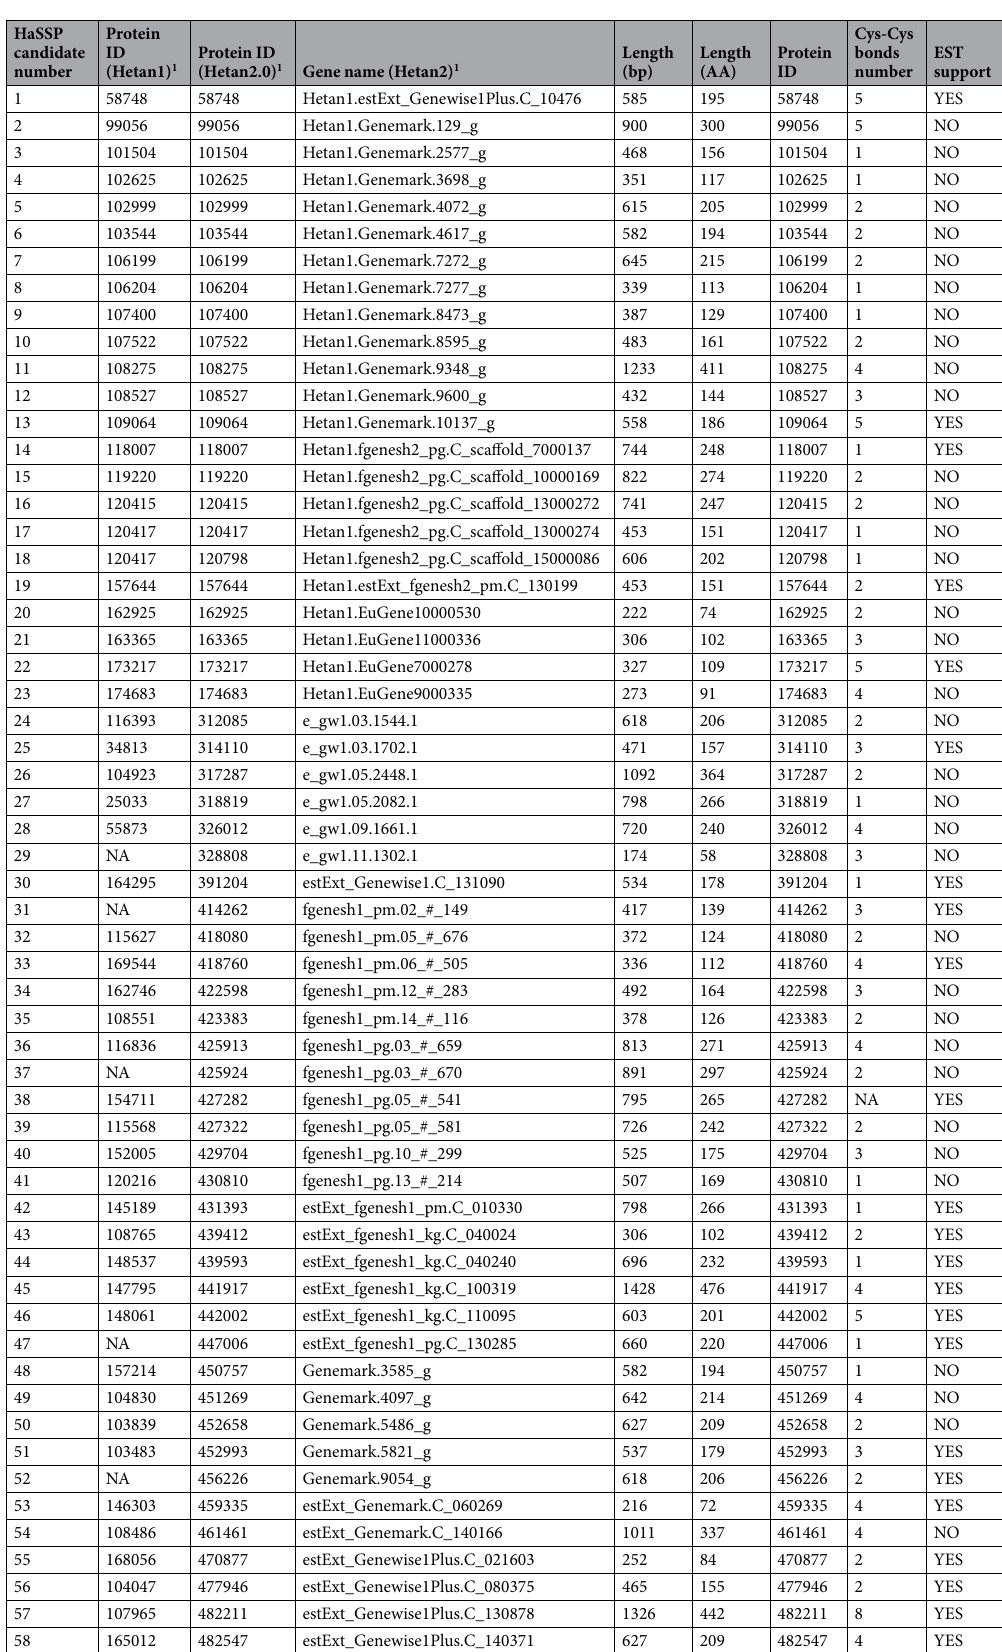
Table 1. Summary of the H. annosum small secreted protein (HaSSP) encoding genes retrieved from the H. annosum TC 32-1 genome annotation. 1